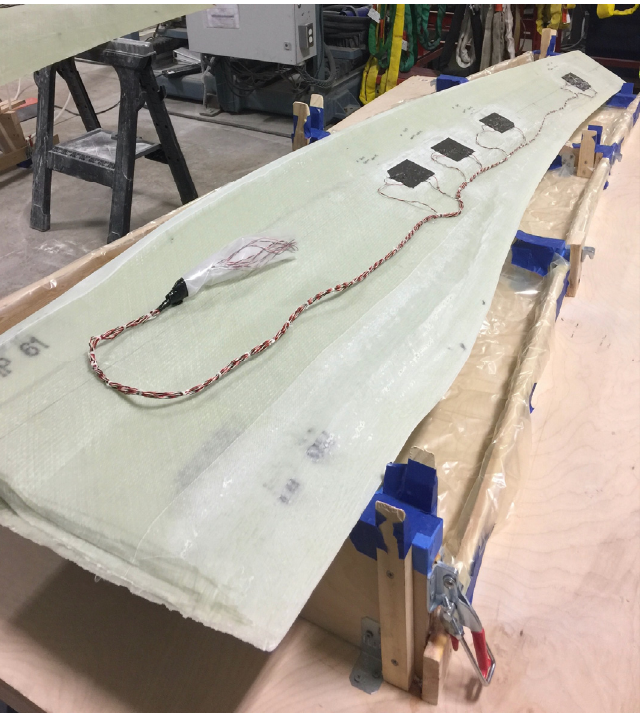
Figure 4. Blade 2 high-pressure skin with strain gage instrumentation for Channels 8–10 (given in Table 1). From left to right these are named SG07-BL2-1100-FB-SC, SG08-BL2-1300-FB-SC, SG09-BL2-1575-FB-SC, and SG10-BL2-2200-FB-SC.